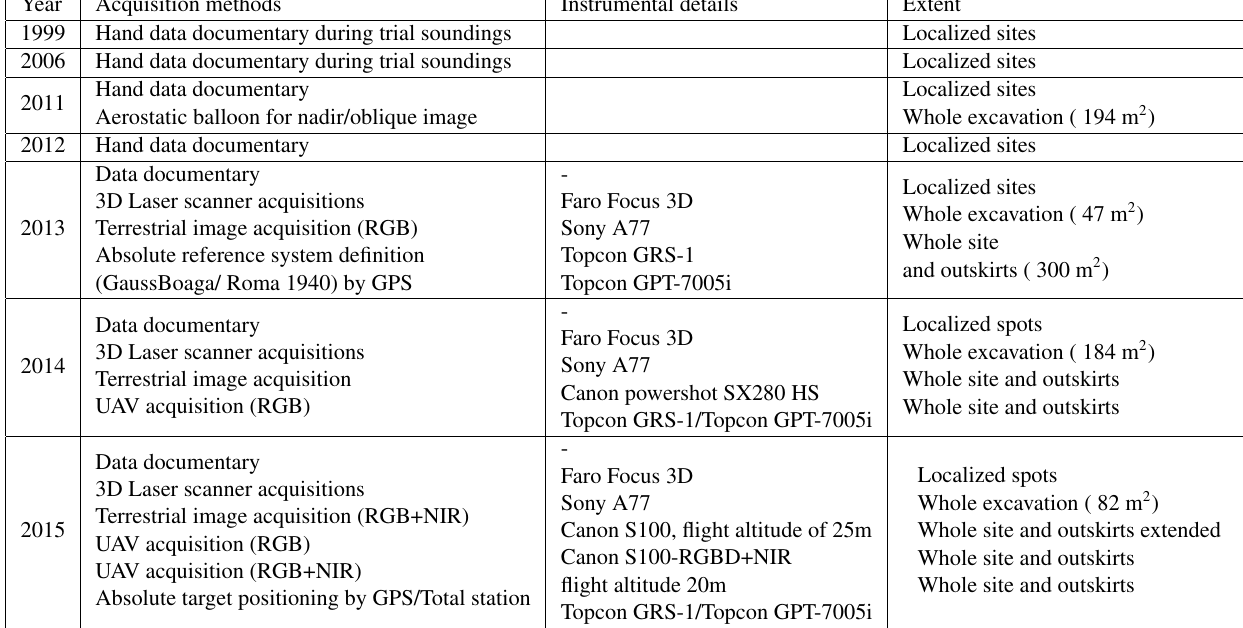
Table 1: List of archaeological datasets by excavation year